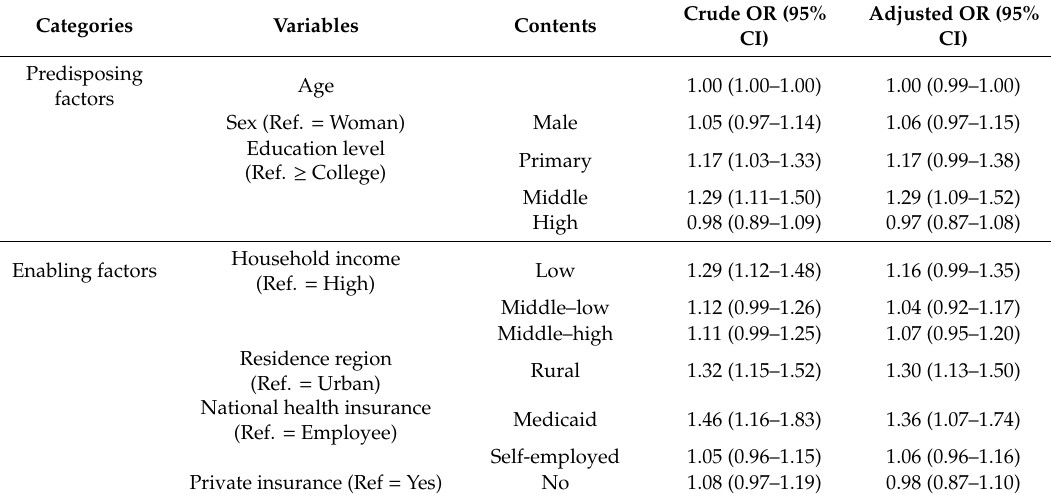
Table 3. Impact of predisposing and enabling factors on dental pain